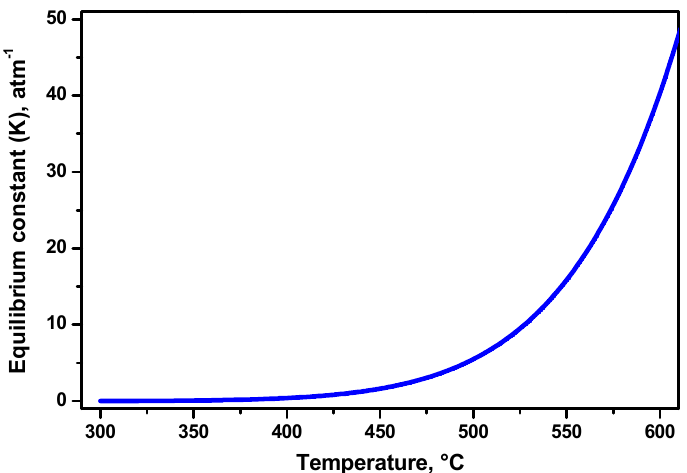
Figure 2. The temperature dependence of the equilibrium constant for the reaction (1) of hydrogen with nickel chloride. Thermodynamic calculations.